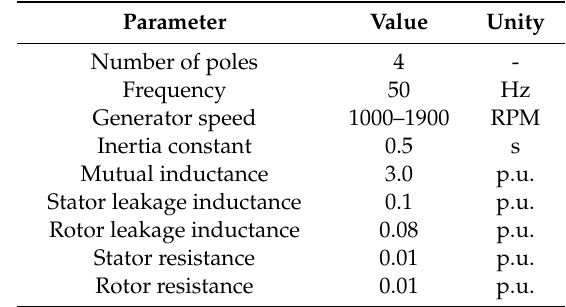
Table 2. Parameters of the Doubly Fed Induction Generator (DFIG).